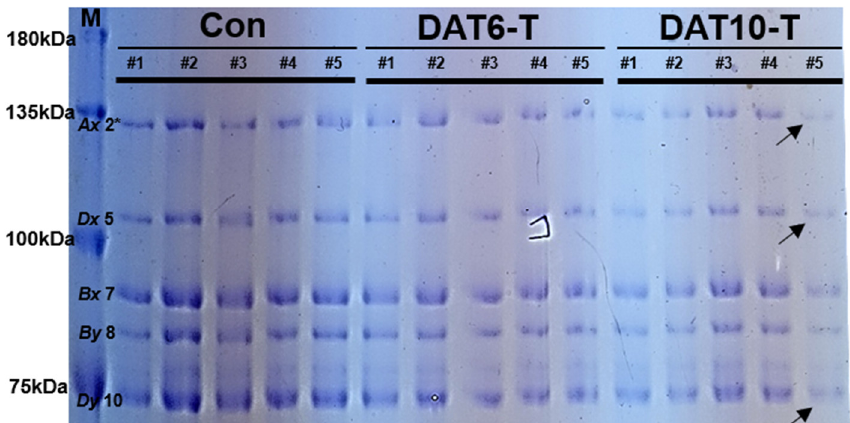
Figure 2. High-molecular weight glutenin subunit (HMW-GS) profiles of spikelets from different sections of the spike (#1–5, Figure 1A) of heat-treated plants. Glutenins were extracted from ma- ture seeds harvested from high-temperature stress-treated wheat and nontreated control wheat.